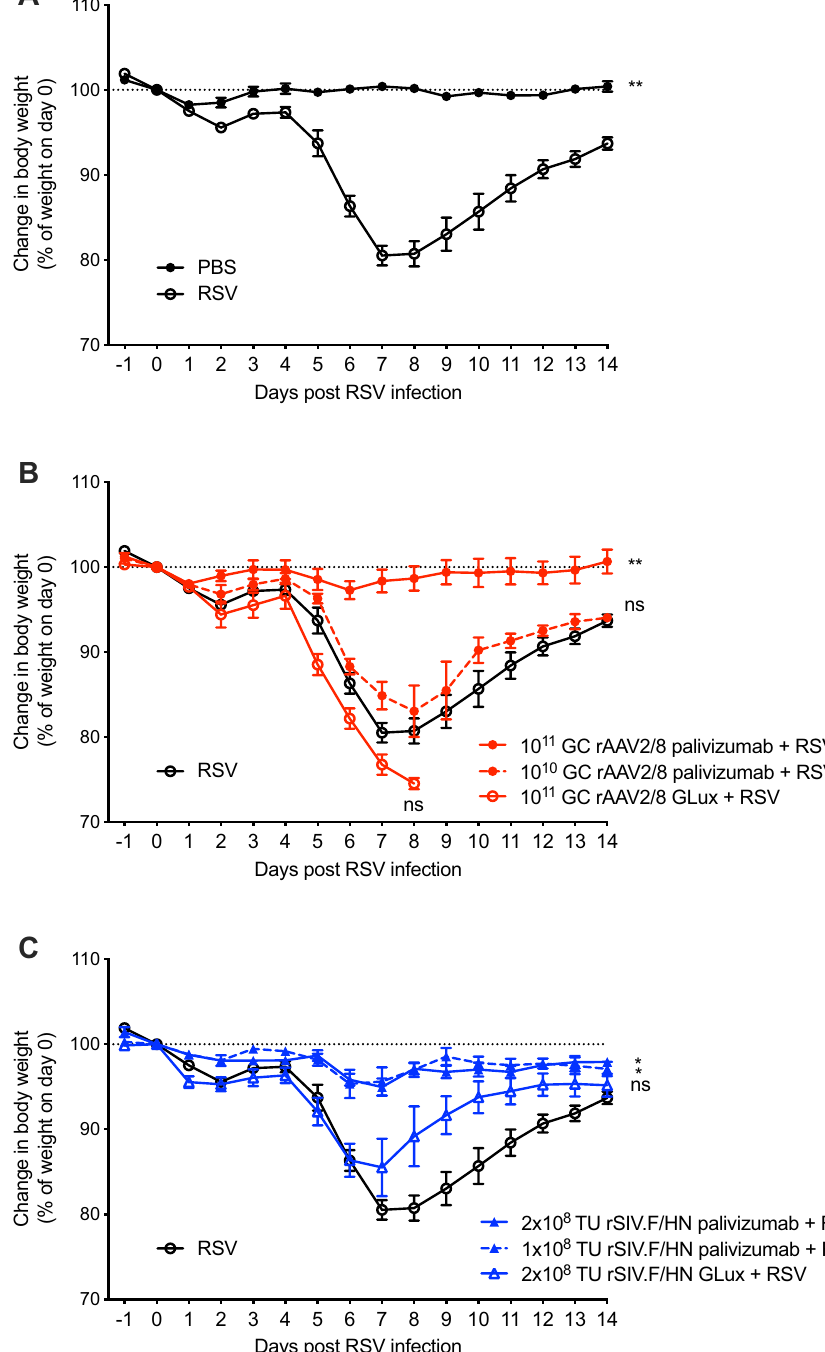
Figure 5. Protection against RSV infection with vector-mediated palivizumab gene transfer. ( A ) Female BALB/c mice (n = 5/group) were infected with 7 × 10 5 FFU of RSV via IN instillation or sham infected with PBS and their percentage weight change was recorded for 14 days. ( B ) Female BALB/c mice (n = 5/group) were administered rAAV2/8 vector expressing palivizumab (10 10 or 10 11 GC), or GLux (10 11 GC) via IM injection: or ( C ) rSIV.F/HN vector expressing palivizumab (10 8 or 2 × 10 8 TTU) or GLux (2 × 10 8 TTU) via IN instillation. Twenty-eight days later, mice were infected with 7 × 10 5 FFU of RSV via IN instillation and their percentage weight was recorded for 14 days. For clarity, symbols and error bars represent mean ± standard error of the mean. Missing weight data after day 7 for the rAAV2/8 GLux dosed mice is due to the application of a pre- determined humane endpoint in this treatment group. The area under the weight loss curve up to day 7 was calculated for each animal and the differences between treatment groups and RSV challenged animals were evaluated using the Kruskal–Wallis test with Dunn’s post hoc multiple comparison